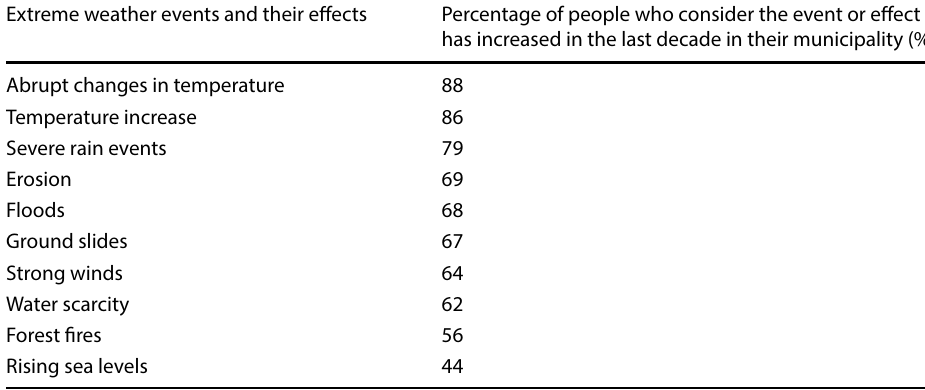
Table 8 Perception on extreme climate events